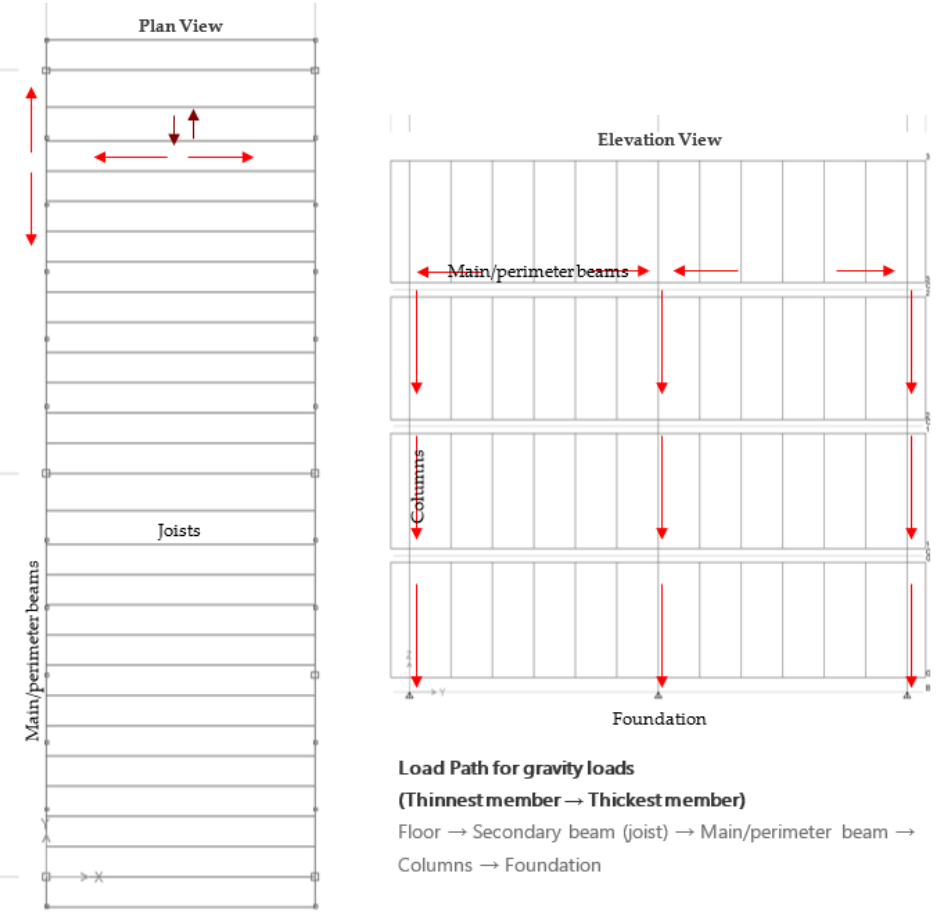
Figure 9. Load path of gravity loads in a corner-supported modular structure shown in plan and elevation views.